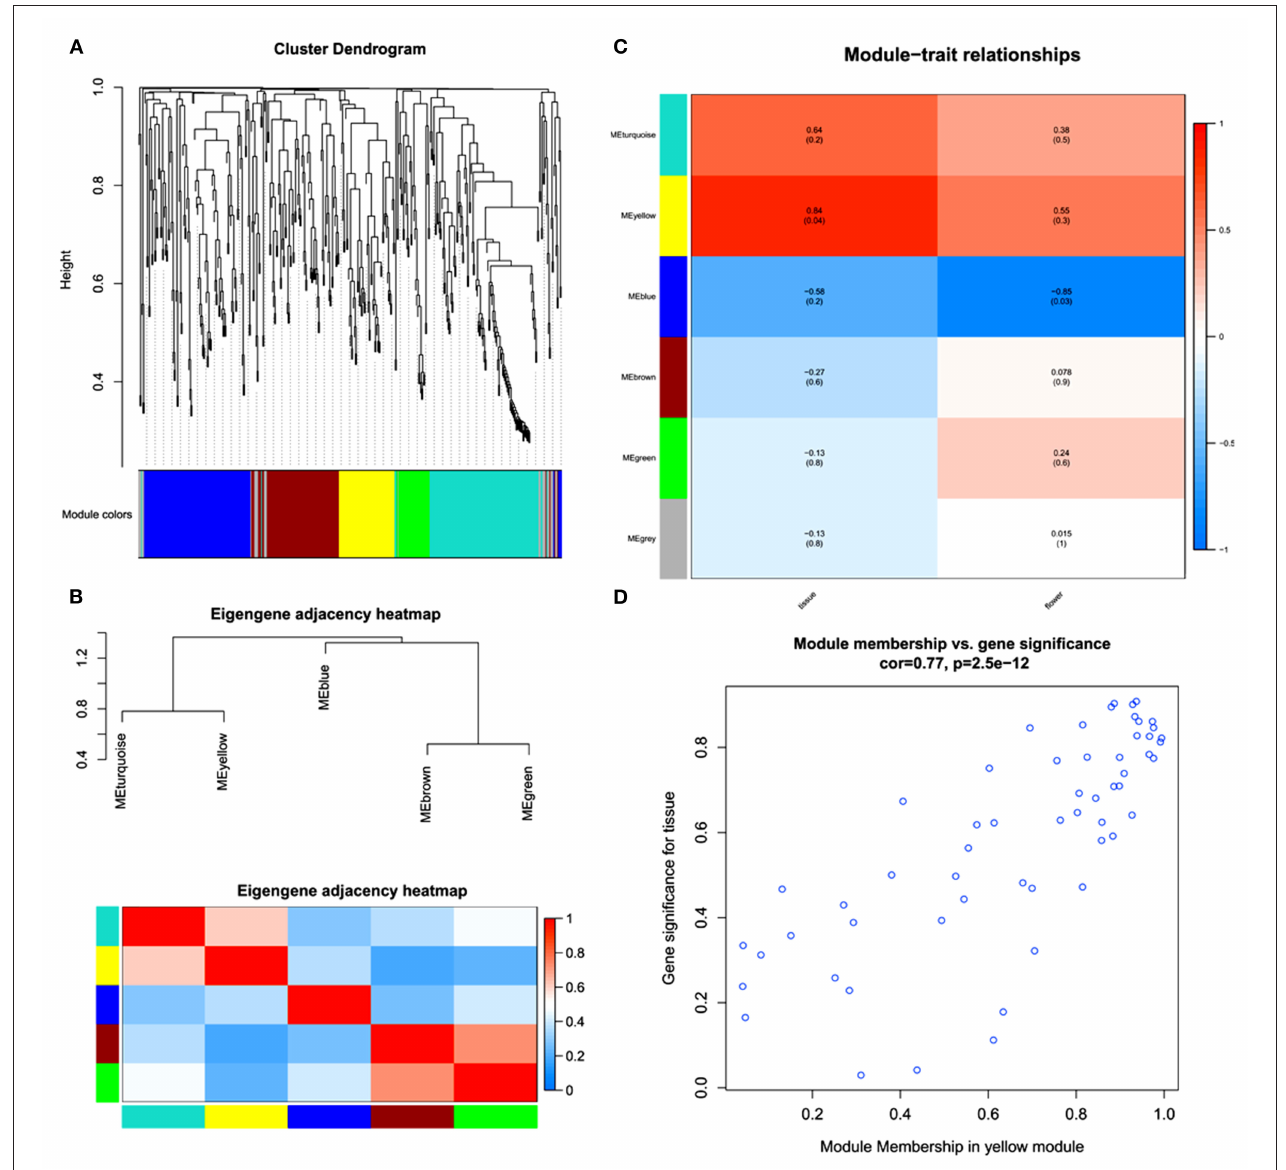
FIGURE 4 | Weighted gene coexpression network analysis (WGCNA); cluster dendrogram (A) , eigengene adjacency heatmap of modules (B) , key modules with expression intensities (C) , and module membership of yellow module for tissue-specific gene significance (D) .